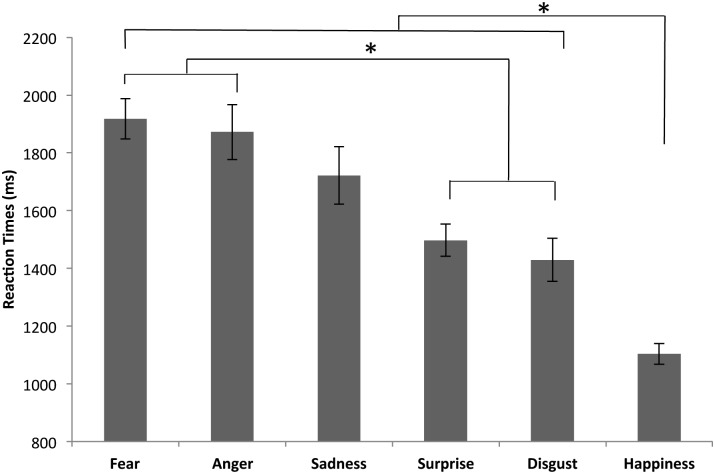
Recognition of emotional facial expressions.RTs are plotted against the six emotions (disgust, happiness, fear, anger, surprise and sadness); bars represent SEM. Significant comparisons are highlighted by an asterisk (p < .05).